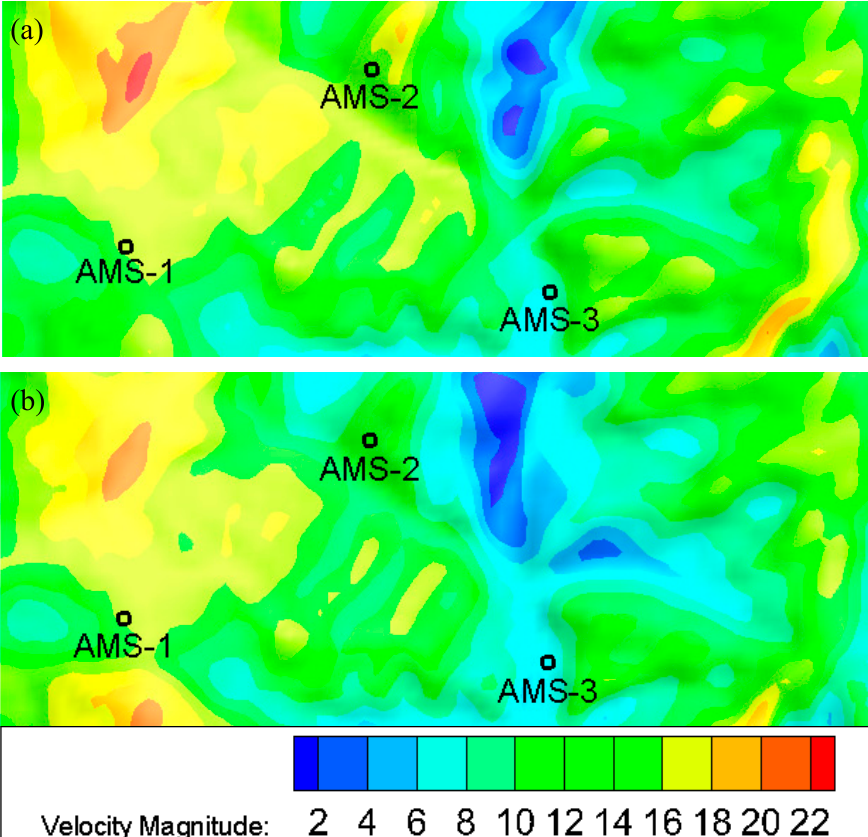
Figure 12. Local distributions of near-surface (10 m AGL) wind speed (m / s) obtained from the ( a ) WRF-CFD-1 simulation and ( b ) WRF-CFD-2 simulation, 16:00 on 22 May 2018.